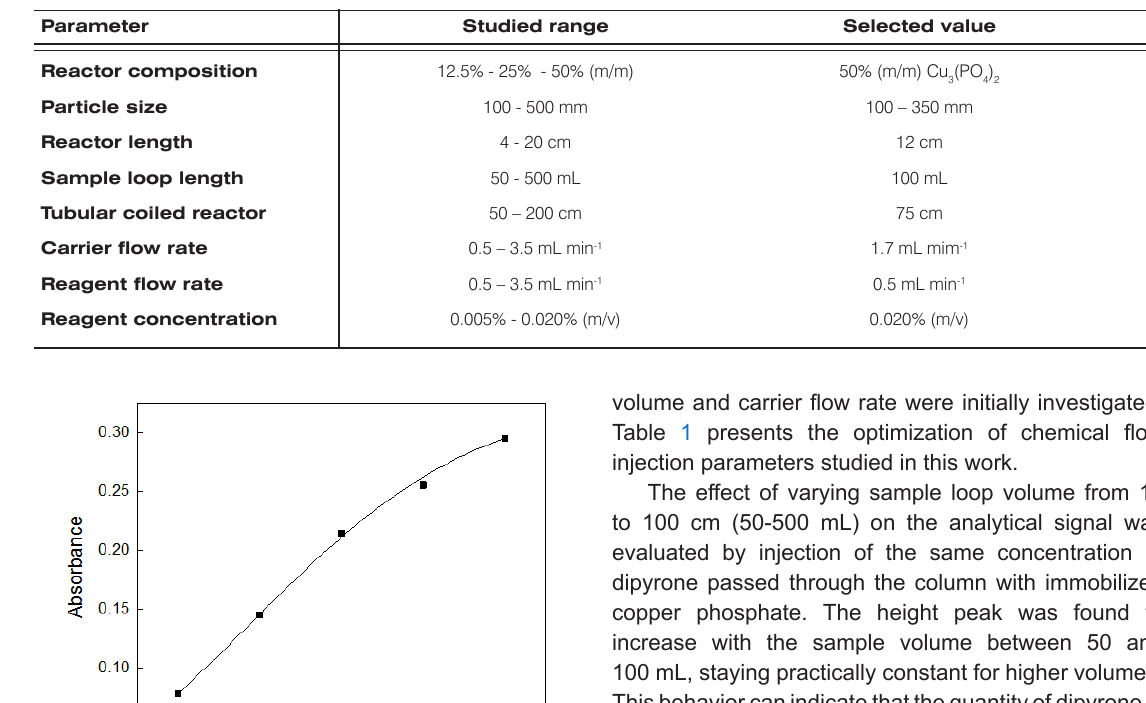
Table 1. Optimization of chemical and flow injection